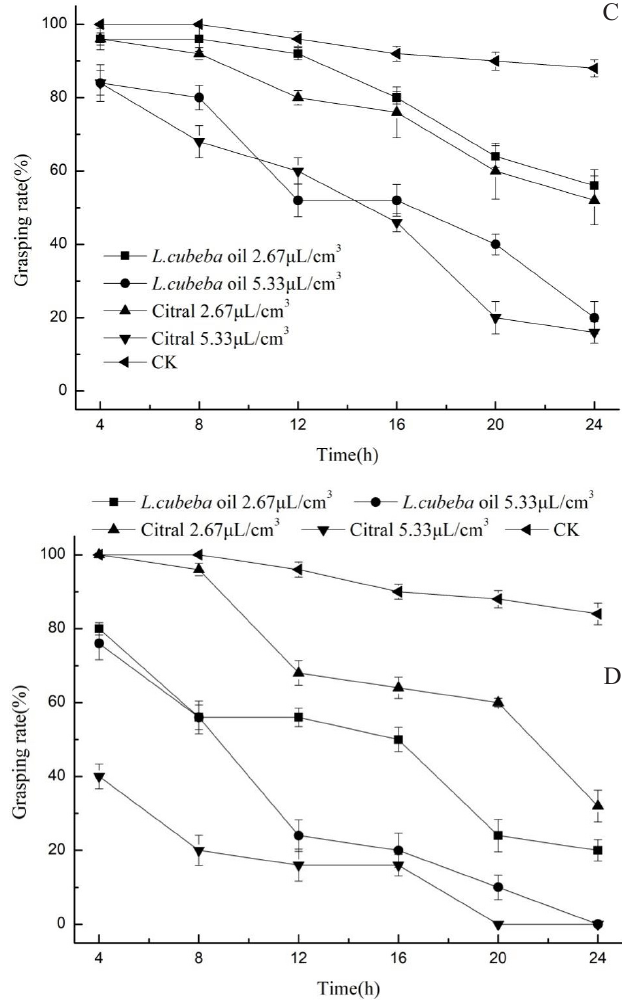
Fig 4 . Effects on grasping ability of workers (C: macroergate, D: microergate) after treating for 24 hours of Litsea cubeba oil and